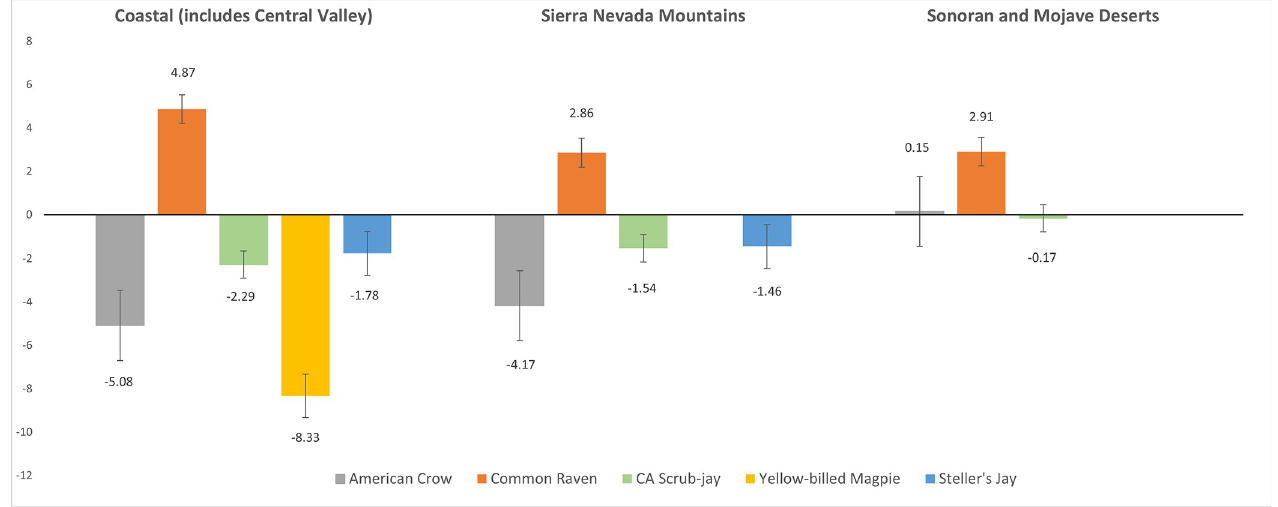
Fig 1. Select corvid species population trends in three Bird Conservation Regions (2004–2019): Relative abundance change (%) per year and standard errors.